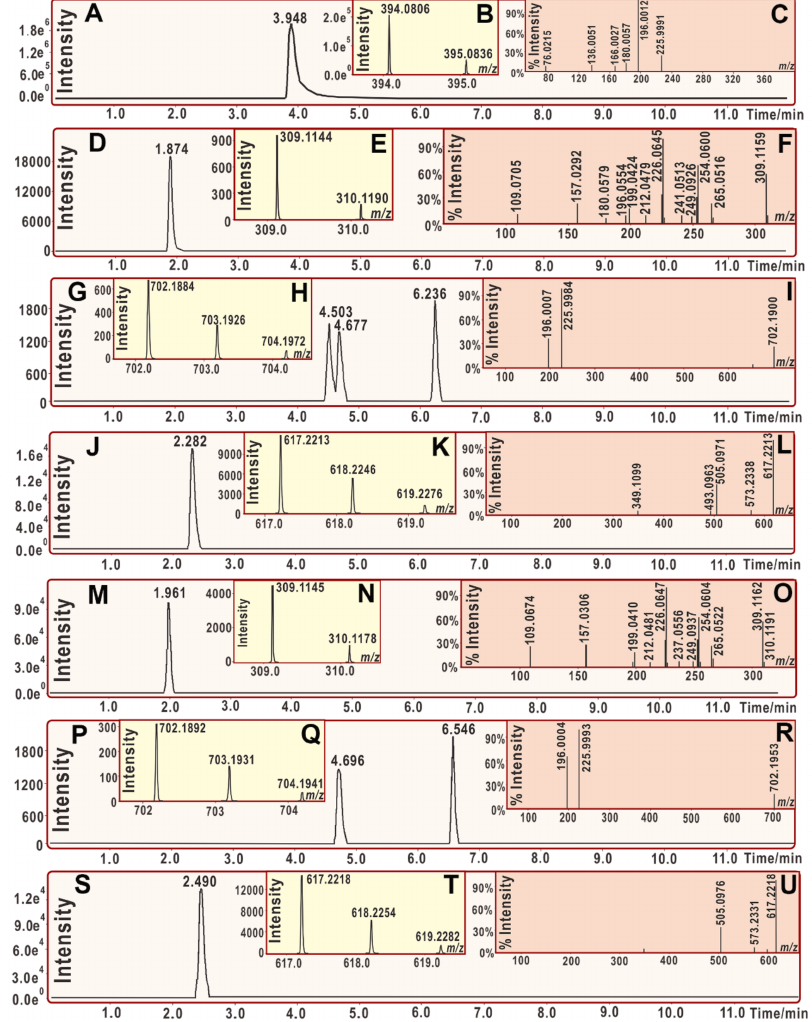
Figure 4. The main results of UPLC-MS analysis:( A , Chromatogram of DPPH • when the formula C 18 H 12 N 5 O 6 was extracted; B , Primary MS spectra of DPPH • ; C , Secondary MS spectra of DPPH • ; D , Chromatogram of moracin C when the formula [C 19 H 18 O 4 -H] − was extracted; E , Primary MS spectra of moracin C; F , Secondary MS spectra of moracin C; G , chromatogram of RAF product of moracin C-DPPH when the formula [C 37 H 29 N 5 O 10 -H] − was extracted; H , primary MS spectra of RAF product of moracin C-DPPH; I , secondary MS spectra of RAF product of moracin C-DPPH; J , chromatogram of RAF product of moracin C-moracin C when the formula [C 38 H 34 O 8 -H] − was extracted; K , primary MS spectra of RAF product of moracin C-moracin C; L , secondary MS spectra of RAF product of moracin C-moracin C; M , Chromatogram of iso -moracin C when the formula [C 19 H 18 O 4 -H] − was extracted; N , Primary MS spectra of iso -moracin C; O , secondary MS spectra of iso -moracin C; P , chromatogram of RAF product of iso -moracin C-DPPH when the formula [C 37 H 29 N 5 O 10 -H] − was extracted; Q , primary MS spectra of RAF product of iso -moracin C-DPPH; R , secondary MS spectra of RAF product of iso -moracin C-DPPH; S , chromatogram of RAF product of iso -moracin C- iso -moracin C when the formula [C 38 H 34 O 8 -H] − was extracted; T , primary MS spectra of RAF product of iso -moracin C- iso -moracin C; U , secondary MS spectra of RAF product of iso -moracin C- iso -moracin